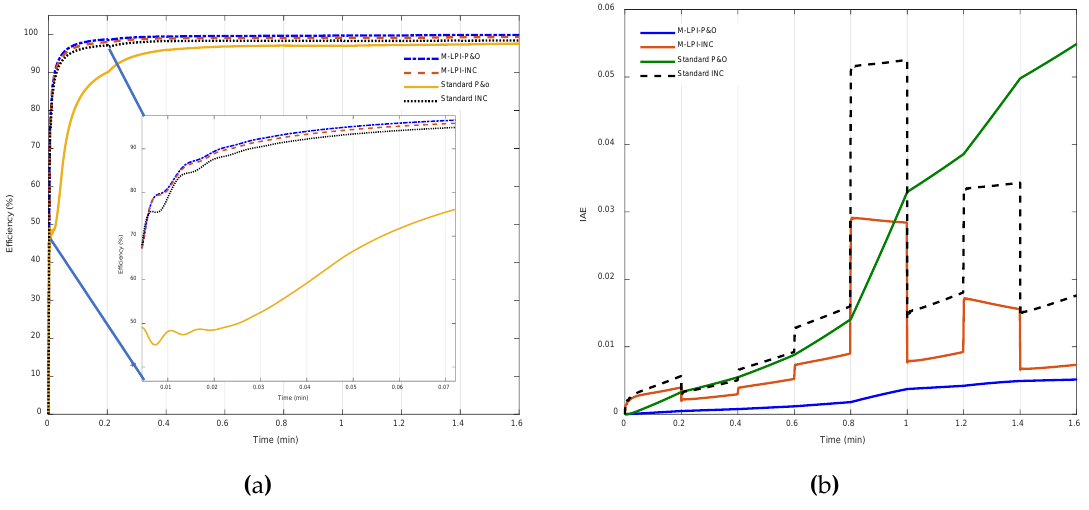
Figure 17. ( a ) E ffi ciency of the modified P&O and INC algorithm, ( b ) Figure 17. ( a ) Efficiency of the modified P&O and INC algorithm, ( b ) error.